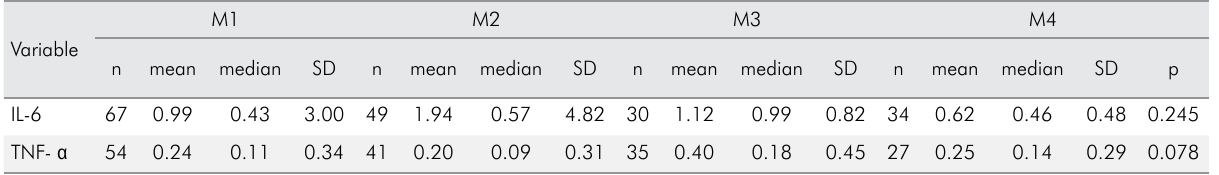
Table 4. Interleukin-6 (IL-6) (pg/mg protein) and tumour necrosis factor alpha (TNF- α ) (pg/mg protein) levels at the 4 treatment